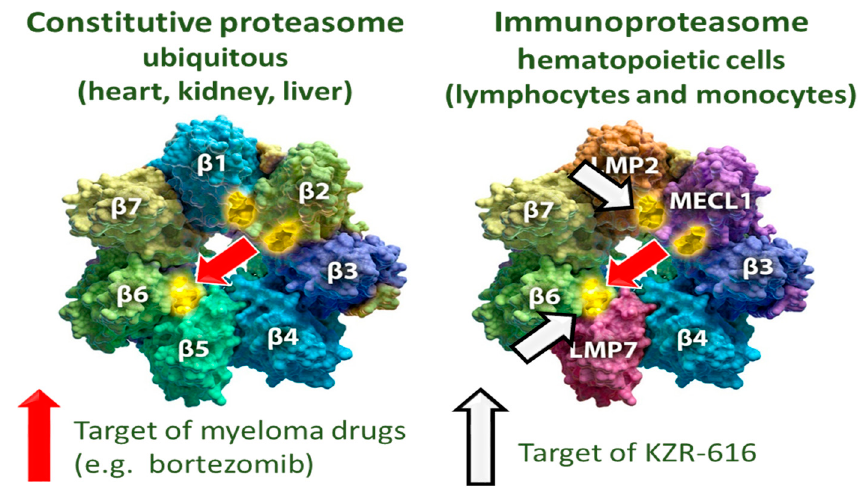
Figure 1. Proteasome subunit composition.